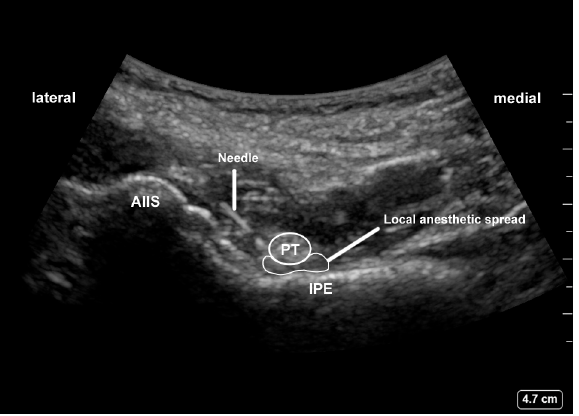
Figure 1. Pericapsular nerve group (PENG) block: AIIS, anterior inferior iliac spine; IPE, iliopubic eminence; PT, psoas tendon.